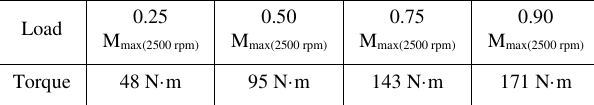
Fig. 1. Operating points of the engine recorded during accomplished road tests Table 2. The engine’s operating points considered in the control task